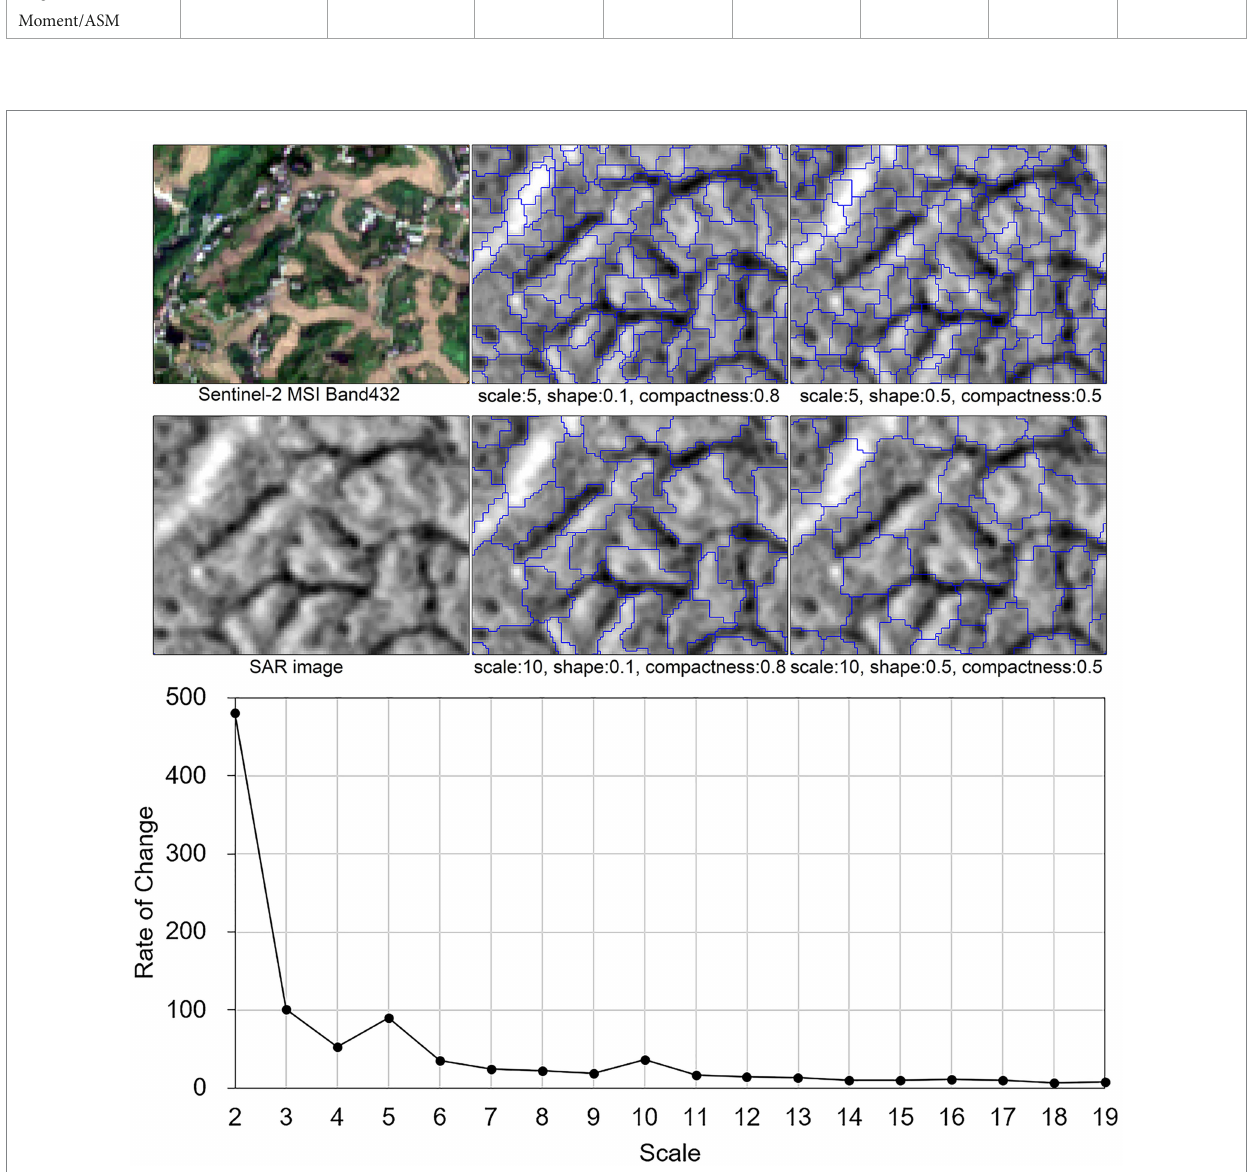
FIGURE 6 Multiresolution segmentation results with different segmentation parameters and rate of change (ROC) of the local